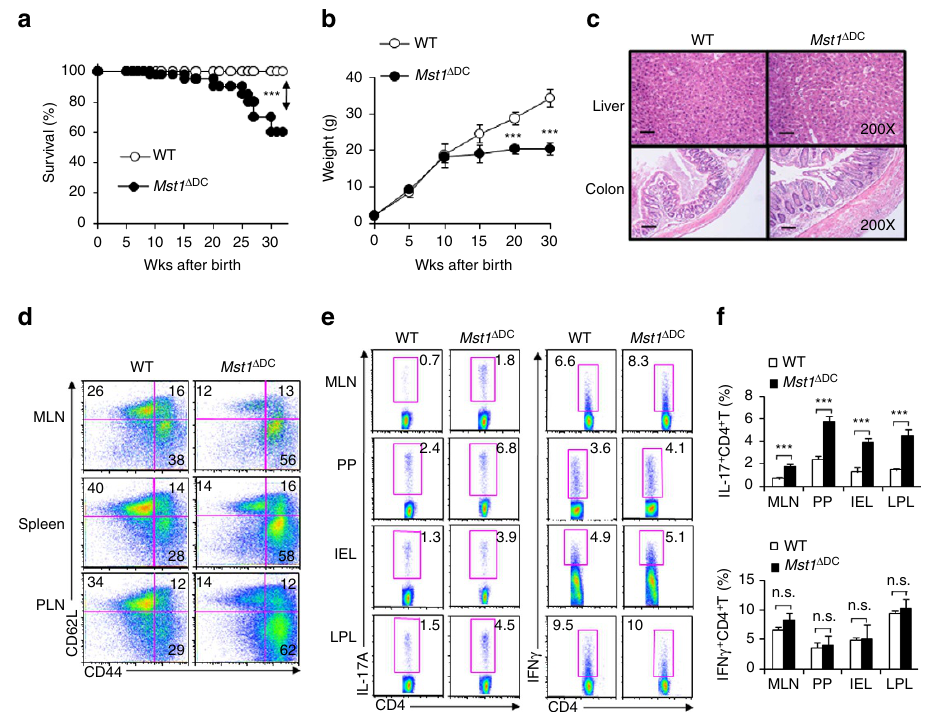
Figure 1 | DC MST1 deficiency leads to spontaneous diseases. ( a ) Kaplan–Meier plots of WTand Mst1 D DC mouse survival after birth are shown ( n ¼ 20). ( b ) Body weights of the WT and Mst1 D DC mice after birth are summarized ( n ¼ 20). ( c ) H&E staining of hepatic and intestinal tissues from sex- and age-matched WTand Mst1 D DC mice at 20 weeks after birth is presented. Scale bars, 100 m m. ( d ) DC MST1 deficiency leads to more CD44 high CD62L low cells among CD4 þ Tcells than WTcontrol mice at 20 weeks after birth. Gating strategies for determining the percentage of CD4 þ TCR þ CD44 high CD62L low cells are showed in Supplementary Fig. 4C. Intracellular IL-17A and IFN- g expression of CD4 þ Tcells isolated from MLN, PP, IEL and LPL in WTand Mst1 D DC mice with a typical figure displayed ( e ) and the frequencies of positive cells summarized ( f ). Data are representative of three to four independent experiments (mean ± s.d.; n ¼ 4). *** P o 0.001, compared with the indicated groups. n.s., not significant. P -values were determined using Student’s t